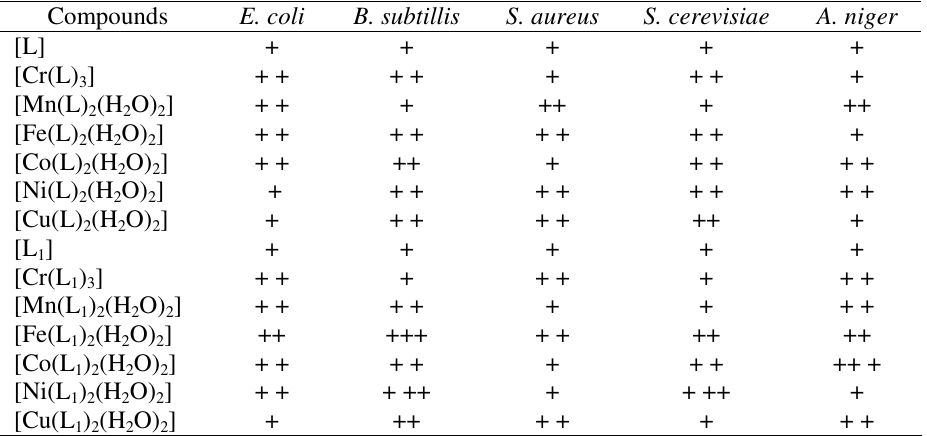
Table 7. Antimicrobial activity of Schiff base ligand L, ligand L